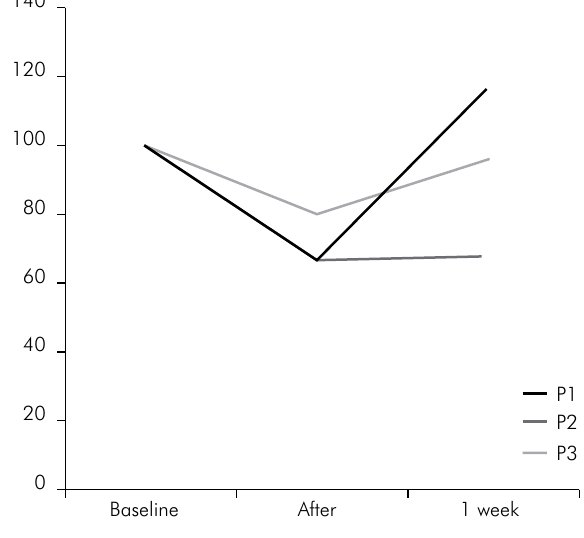
Figure 2. Relative percentage of pulp blood flow in the upper left central incisor of each